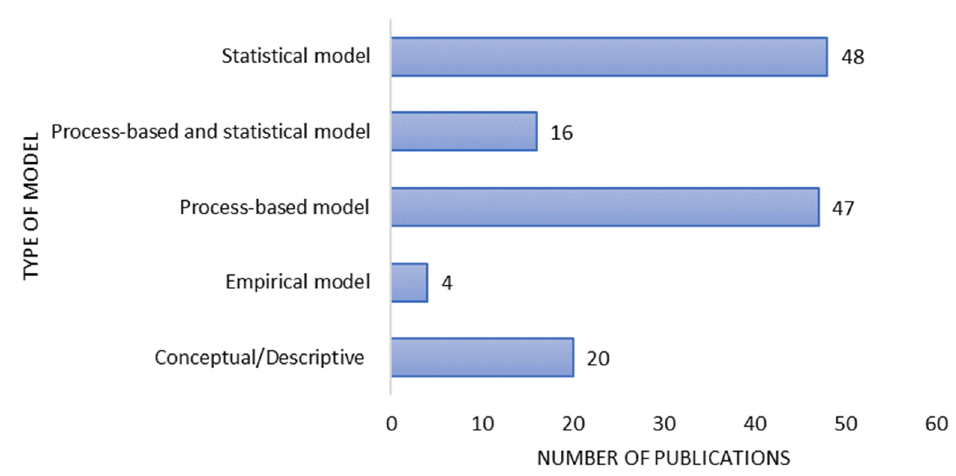
Figure 4. Types of modelling approach used in the studies in the Lake Tana basin.